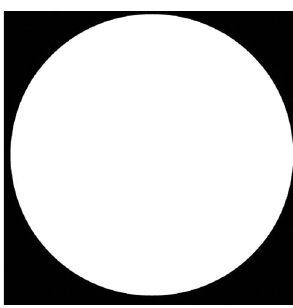
FIG. 13. First quarter — II.